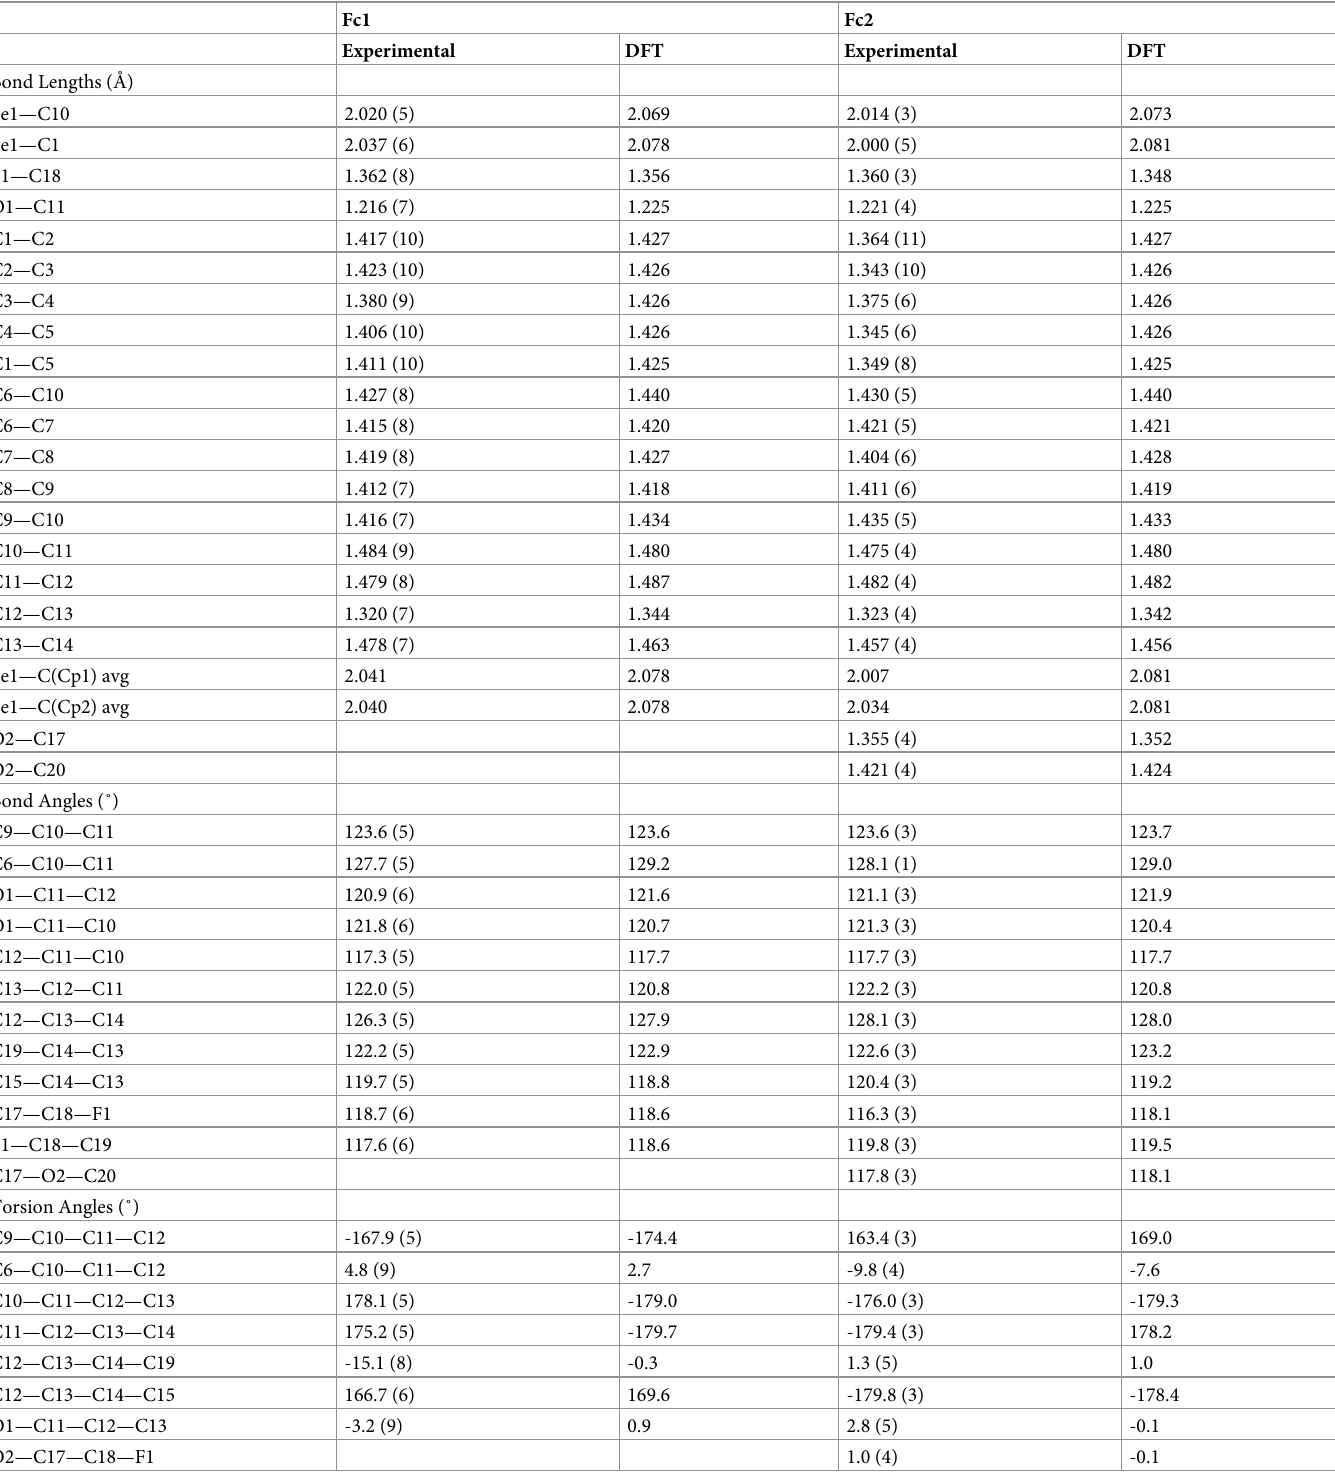
Table 1. Selected experimental and calculated bond lengths and